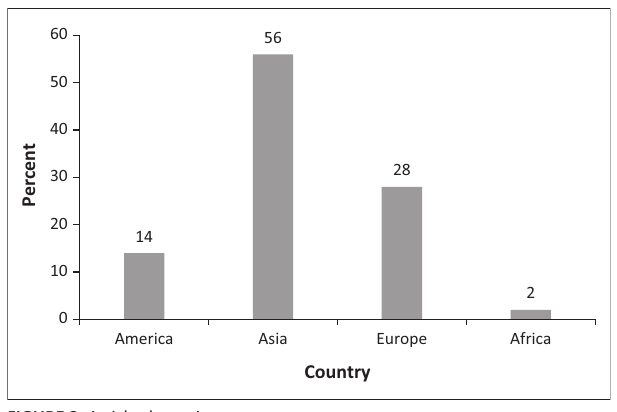
1. Qualitative (44 % ) 2. Quantitative (50 %